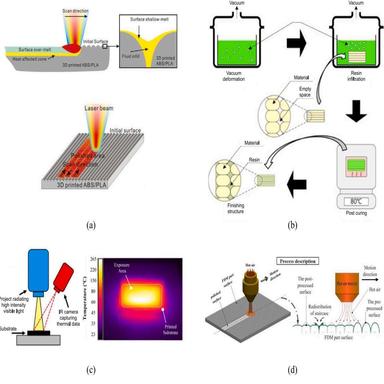
(a) The utilized strain rig for ionizing radiation , and (b) vertical milling machine for machining experiments .